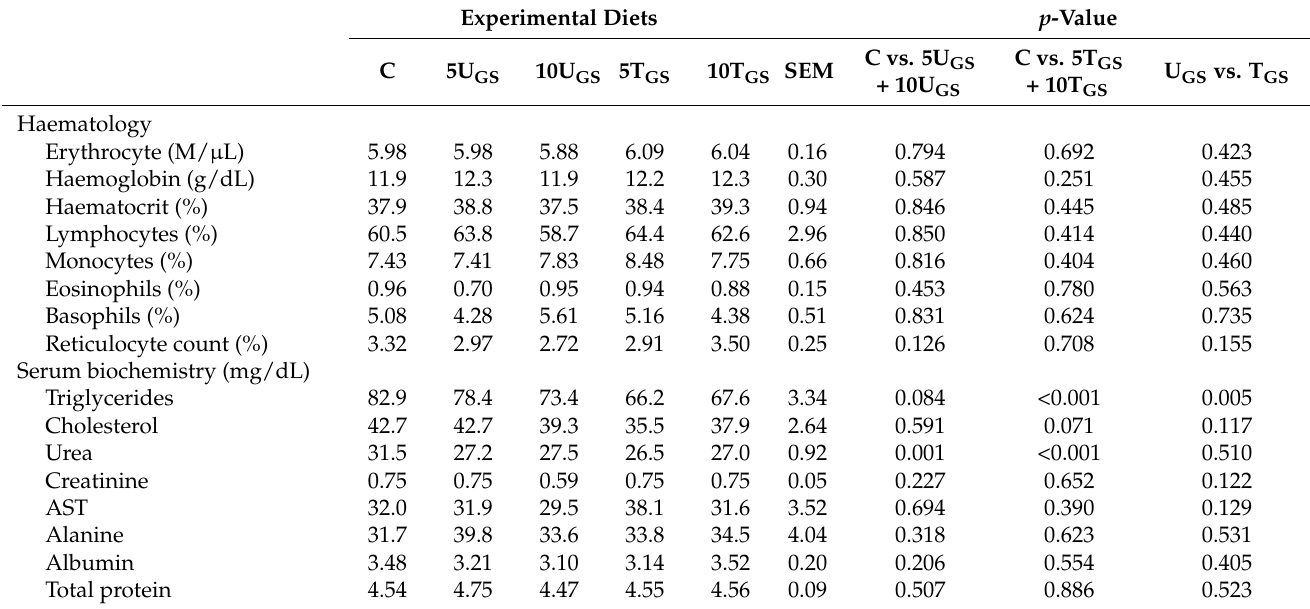
Table 5. Effect of the experimental diets on blood hematology and serum biochemistry ( n =